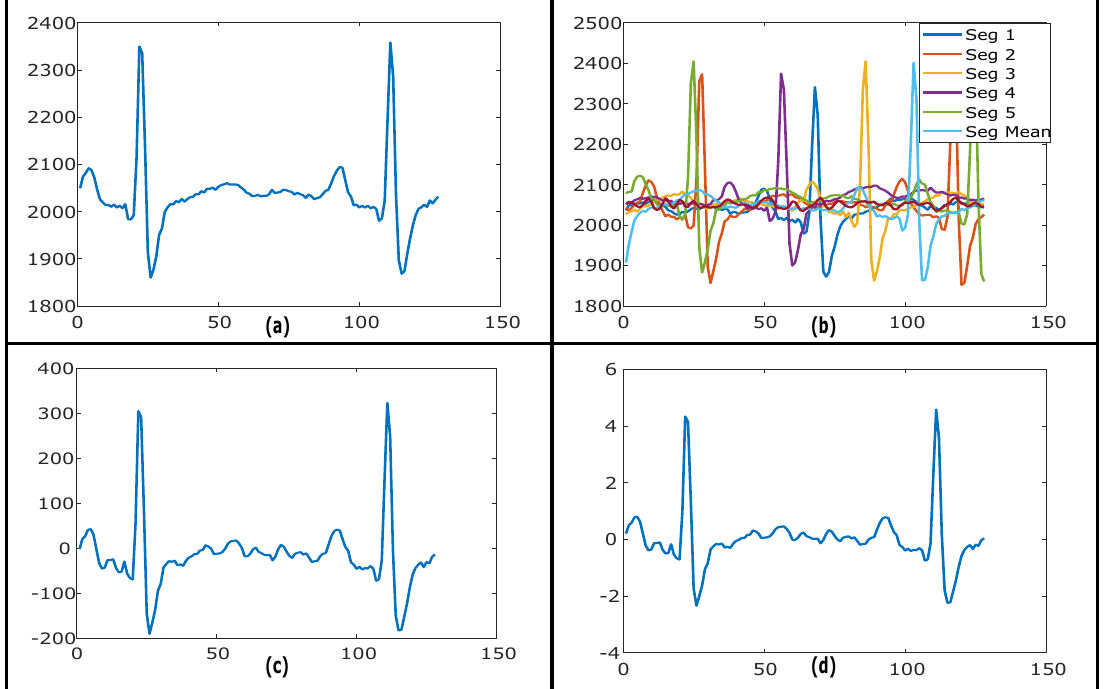
Figure 5. ( a ) ECG signal after basic pre-processing. ( b ) Five segments of ECG baseline activity with computed mean signal. ( c ) ECG signal (left channel) 1 s segment of emotional activity after removing mean of baseline activity. ( d ) After Z-score